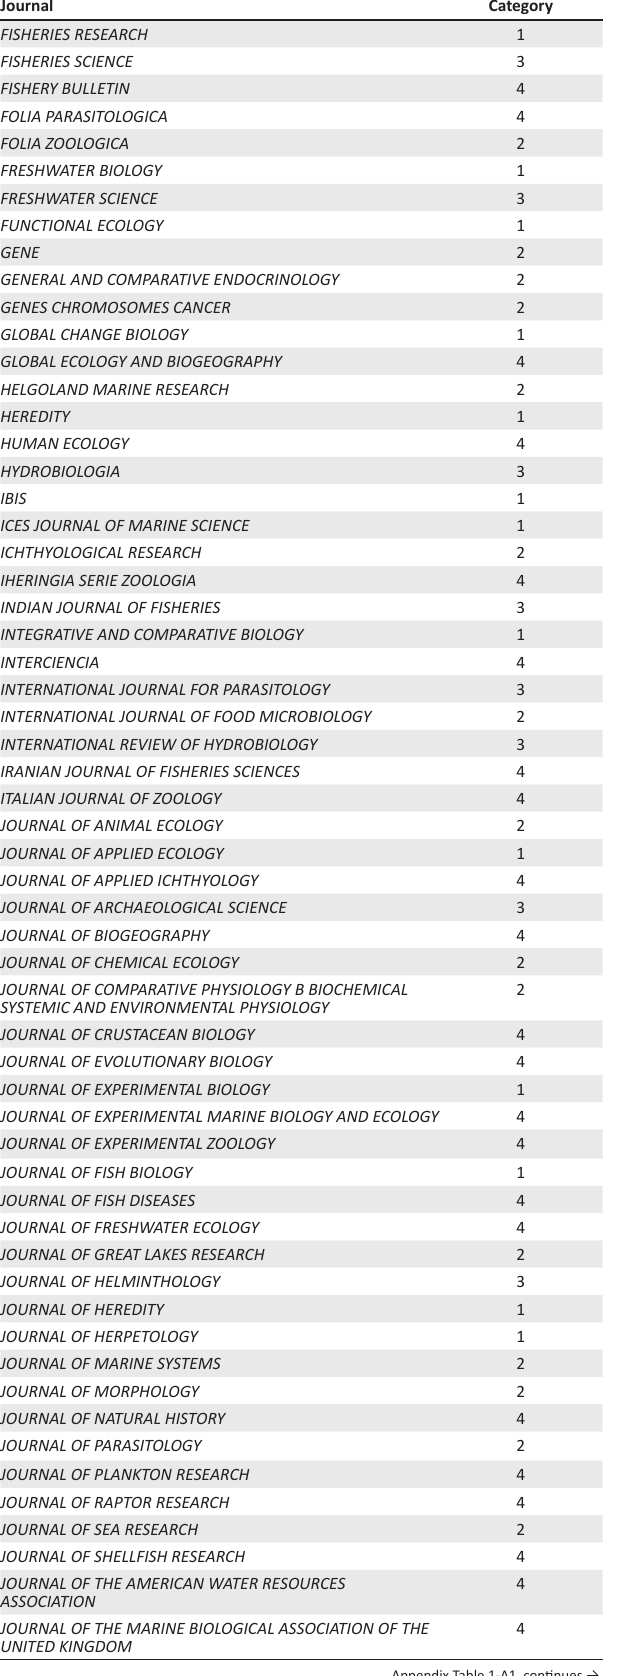
TABLE 1-A1 (Continues…): Categorisation, based on animal ethical requirements, of 250 ISI-rated, peer-reviewed, scientific journals with the most articles relating to fish research, revealed through a Web of Science (Thomson Reuters)